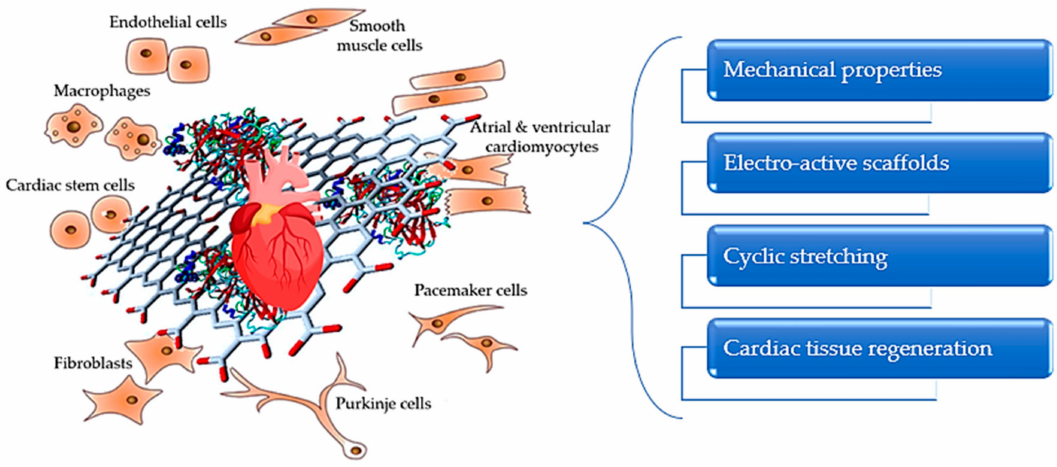
Figure 3. Schematic representation of key features for cardiac tissue